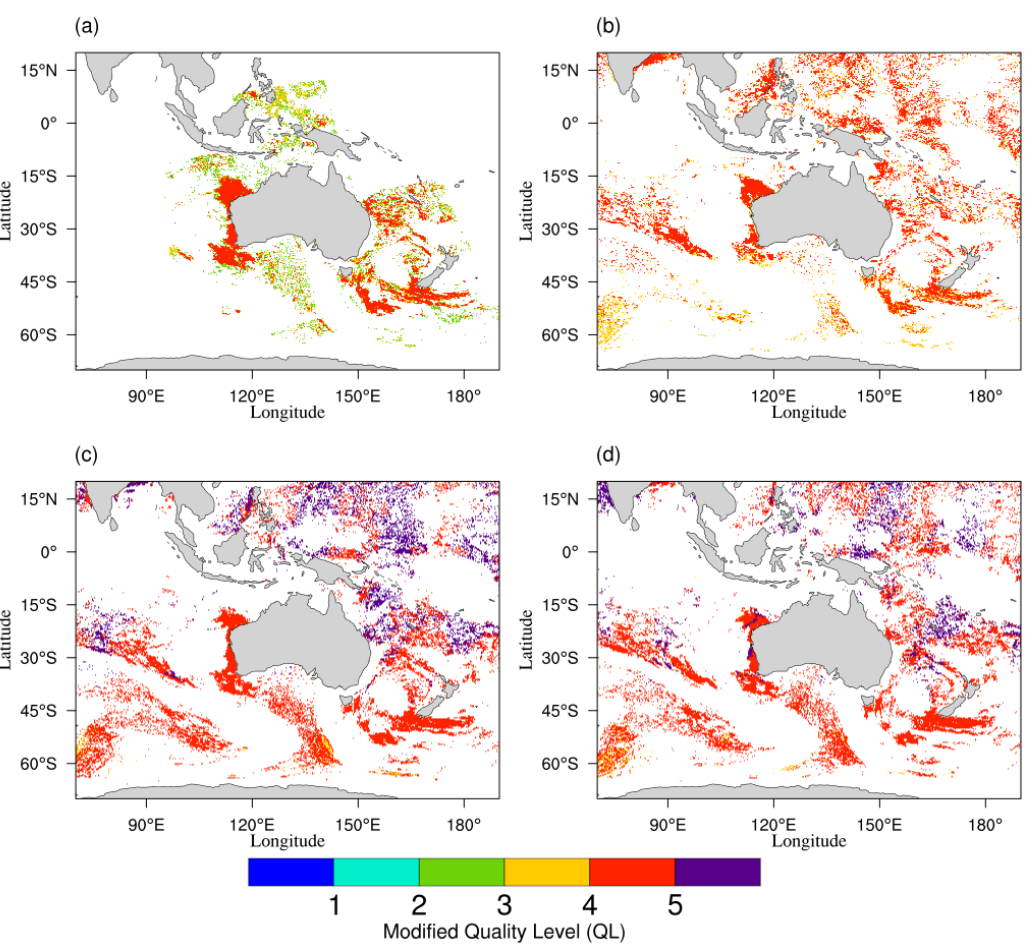
Figure 3. Modified quality level (QL) as per Section 2.2.5 for the fv02 L3C-1day night-time file for ( a ) NOAA-18 AVHRR, ( b ) MetOp-B AVHRR, ( c ) NPP VIIRS and ( d ) N20 VIIRS for 12 December 2018, obtained from